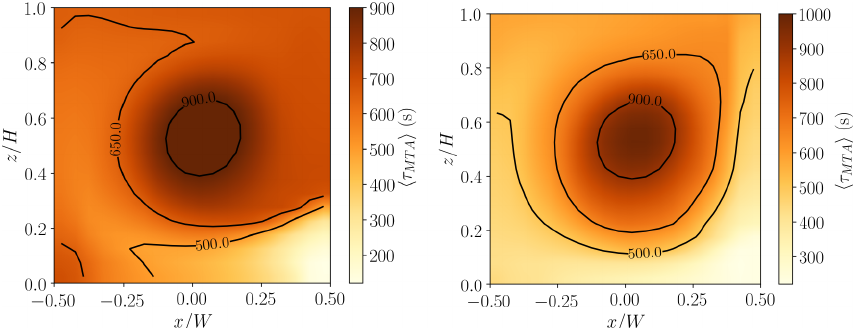
Figure 14. Spanwise-averaged MTA for (a) near-ground and (b) column source. The canyon-averaged MTAs are similar (652s for the NG source and 599s for the CO source); however, the spatial structures are noticeably